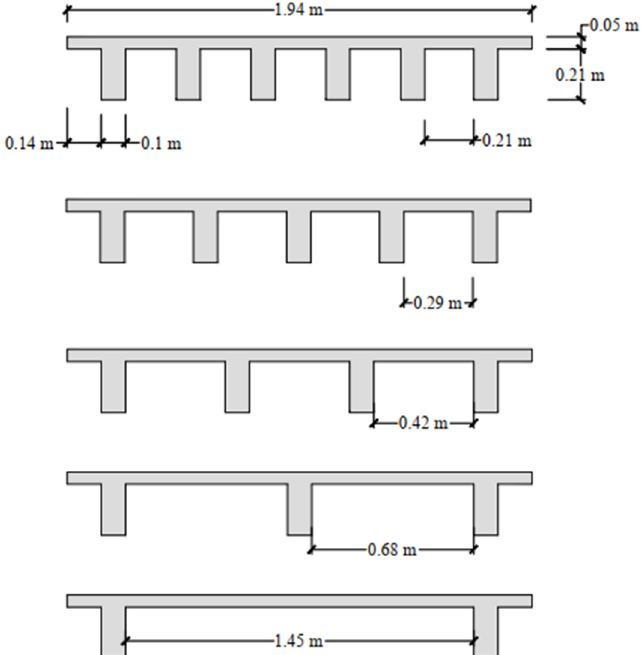
Figure 6. A schematic of the deck configurations with a different number of girders used in the present study.